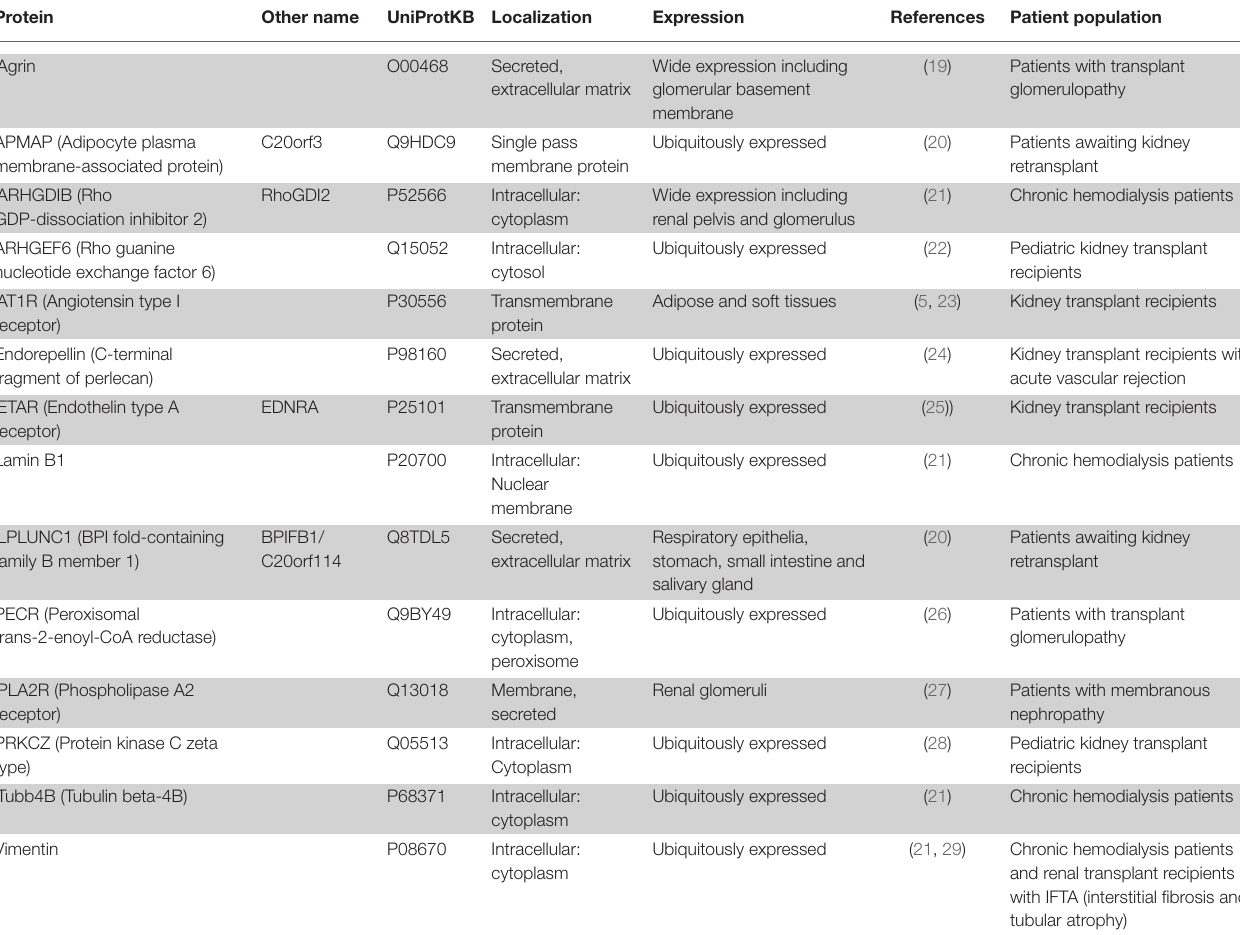
TABLE 1 | Fourteen non-HLA proteins selected based on a literature search in patients with kidney disease or after kidney transplant.